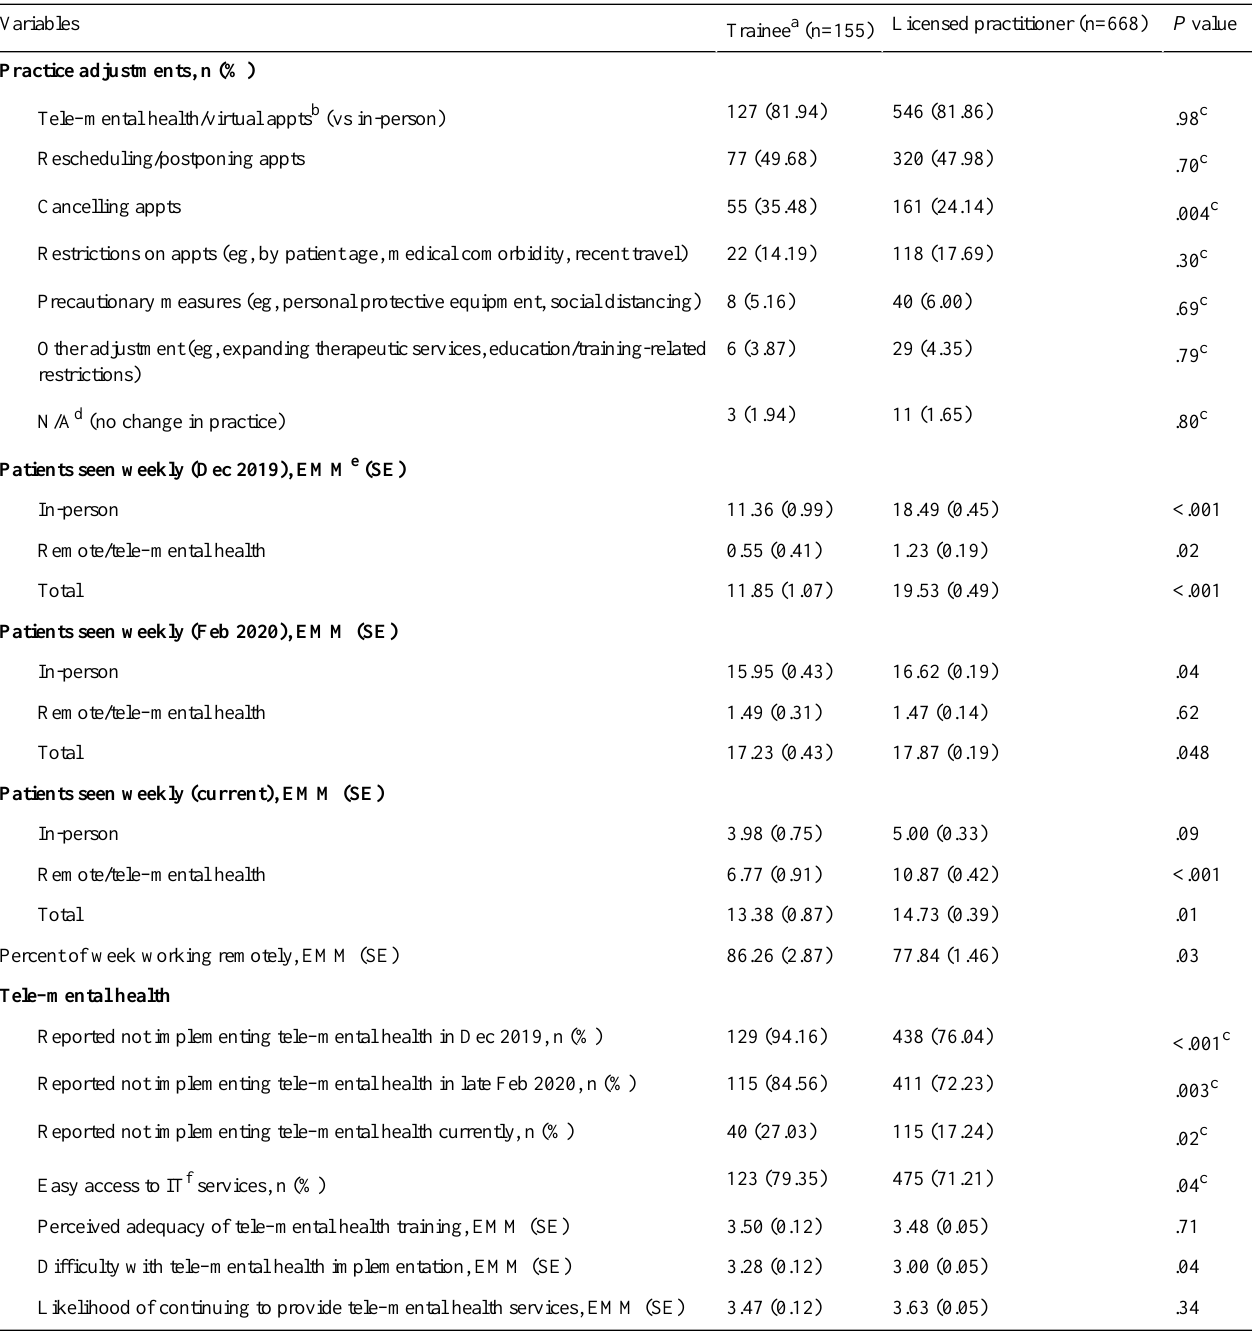
Table 4. Results of chi-squares for practice adjustments and analyses of covariance for patients seen and tele–mental health factors during COVID-19 by provider